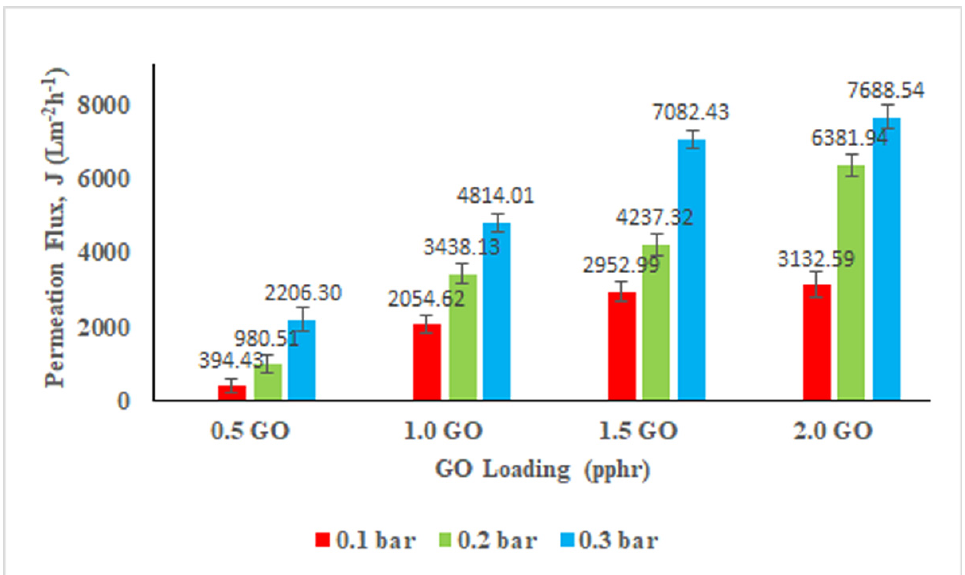
Figure 7. Permeation flux of the membranes tested at different operating pressure.